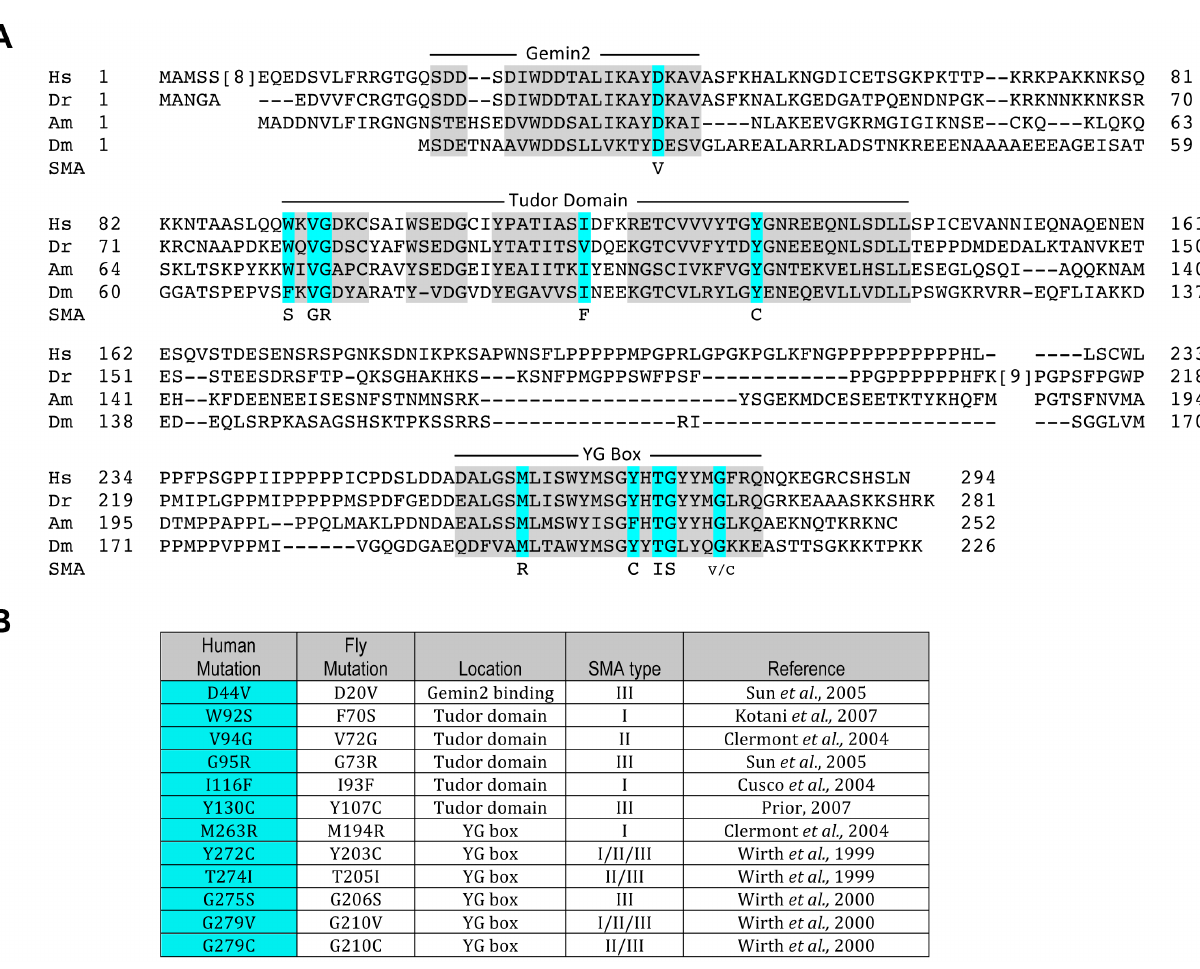
Figure 1. An allelic series of SMN missense mutations in Drosophila . (A) Alignment of SMN orthologues from Homo sapiens (Hs), Danio Rerio (Dr), Apis Mellifera (Am), and Drosophila melanogaster (Dm). Conserved regions, including the Gemin2 binding domain, the Tudor domain and the YG box of SMN, are shaded in gray. Residues known to be mutated in SMA patients are highlighted in aqua. SMA-causing missense residues (SMA) are listed below the highlighted residues. (B) Summary of the human SMA patient mutations that were modeled in Drosophila . These mutations affect all major domains of SMN, and encompass all three classes of SMA severity, with Type I being the most severe and Type III being the mildest form. When multiple SMA types are listed for a given mutation, this indicates that differing phenotypic severities were observed in patients bearing the same mutation.